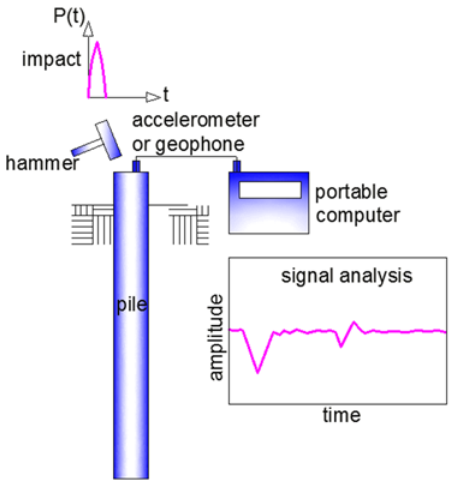
Figure 1. Low ‐ strain pile integrity test by impact echo method. Figure 1. Low-strain pile integrity test by impact echo